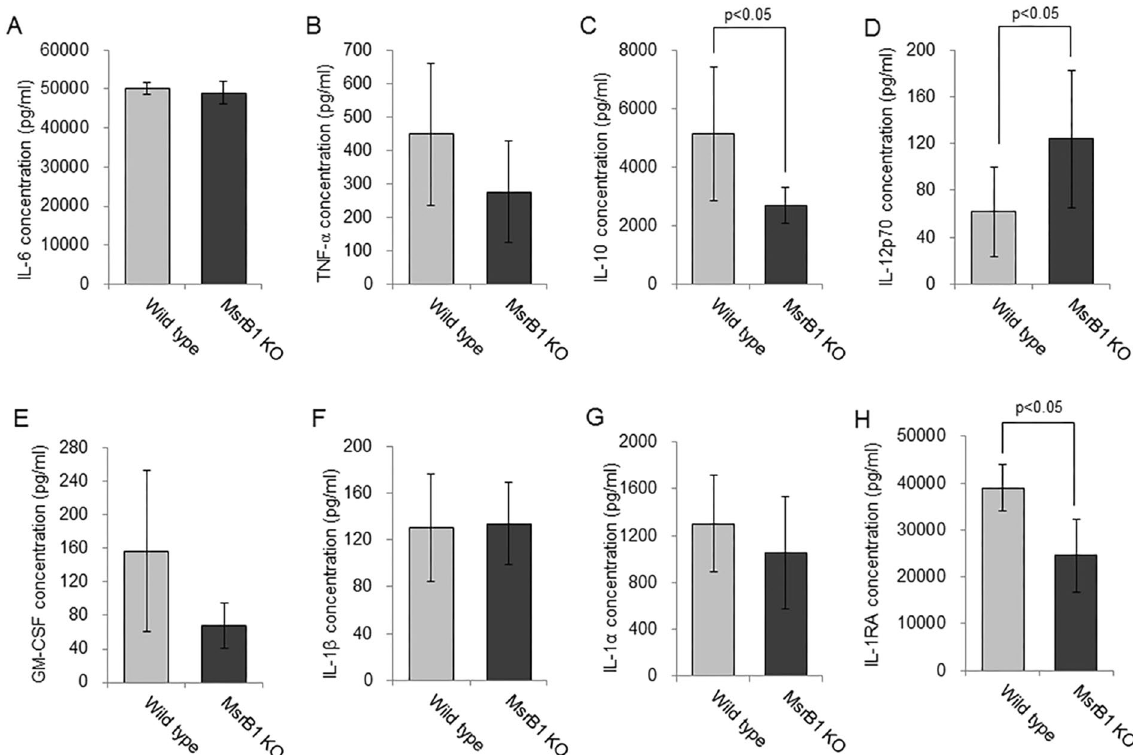
Figure 5. Cytokine protein profiles in WT and MsrB1-KO mouse plasma. ( A – H ) Protein concentrations of IL-6 ( A ), TNF ( B ), IL-10 ( C ), IL-12p70 ( D ), GM-CSF ( E ), IL-1 β ( F ), IL-1 α ( G ), and IL-1RA ( H ) in mouse plasma (n = 8) were measured four hours after intraperitoneal injection of LPS. Error bars represent standard deviation. Data were statistically analyzed by Student’s t-test ( p <